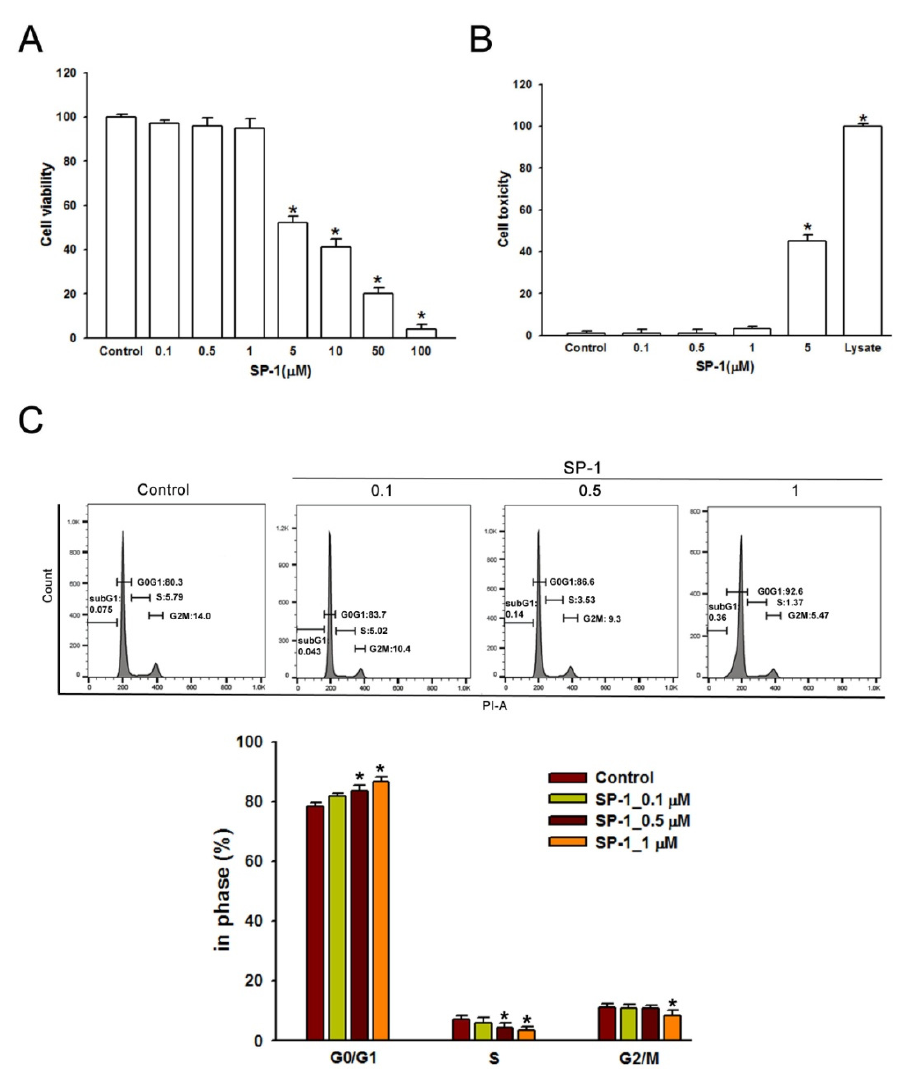
Figure 4. Heteronemin inhibited cell growth and arrested the distribution of cell cycle in human lymphatic endothelial cells. ( A ) LECs were incubated with various doses (0–100 µ M) of heteronemin (indicated as SP-1) in a 96-well plate for 24 h. Cell viability was determined by MTT assay after treatment. The maximal non-toxic dose was chosen for further experiments. ( B ) Cells were treated with SP-1 for 8 h; then, the cytotoxicity was determined using LDH assay. ( C ) Cells were treated with various concentrations of SP-1 for 24 h and were then analyzed using flow cytometry. Histograms represent the percentage of cells in each cell cycle phase. The graph corresponds to the distribution of cell subpopulation percentages expressed as means ± SEM of five independent assays. * p < 0.05 compared with solvent control (0.01% DMSO).